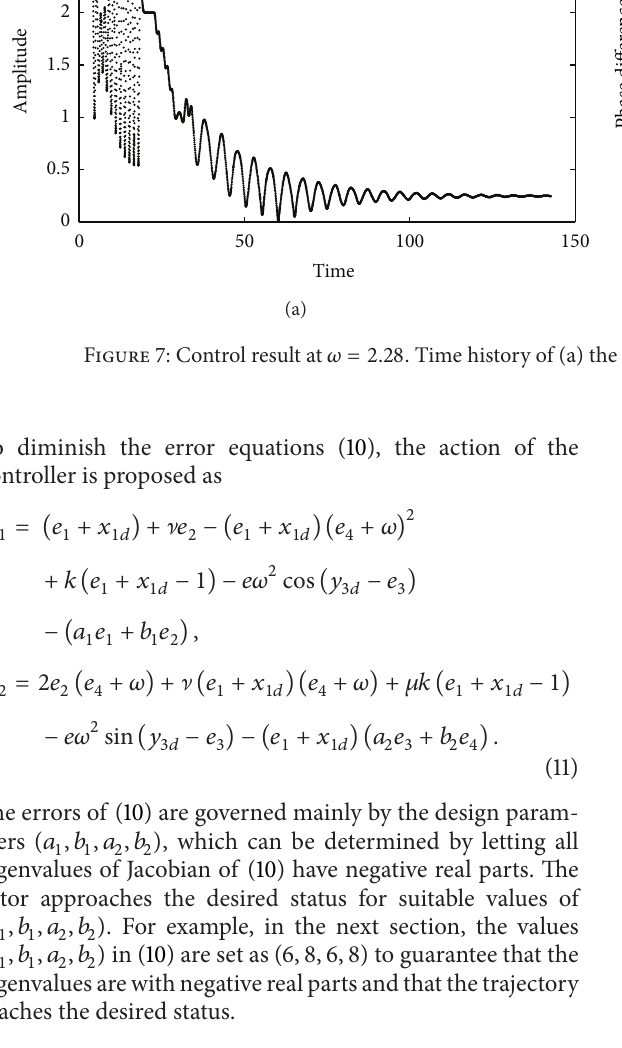
Figure 7: Control result at 𝜔 = 2.28 . Time history of (a) the radial displacement amplitude and (b) phase difference.